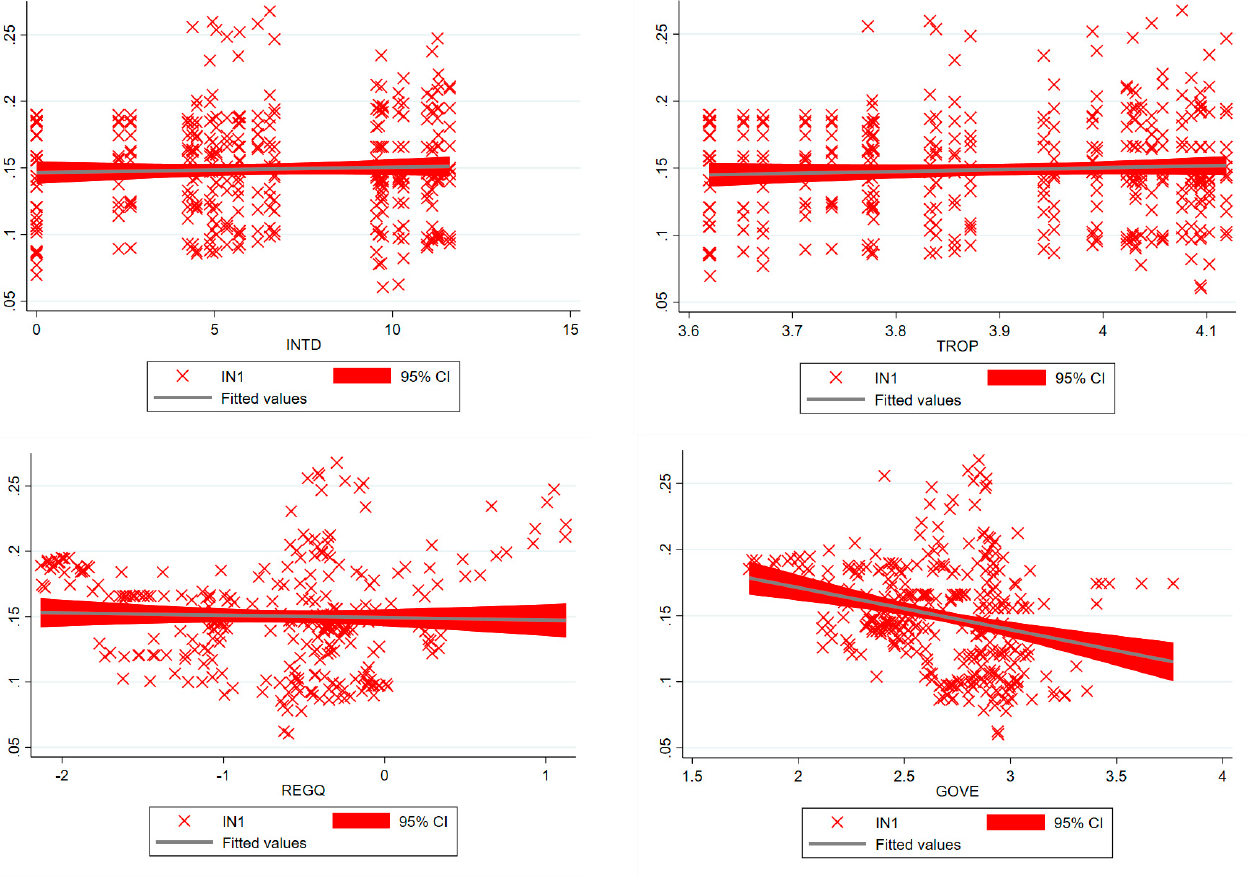
Figure 6. Fi tt ed values for income inequality and globalization dynamics. Note: CI—Con fi dence Figure 6. Fitted values for income inequality and globalization dynamics. Note: CI—Confidence interval. Legend: IN1—The income share of the top 1%, INTD—Global internet di ff usions; TROP— interval. Legend: IN1—The income share of the top 1%, INTD—Global internet diffusions; TROP— Global trade openness. Global trade openness.